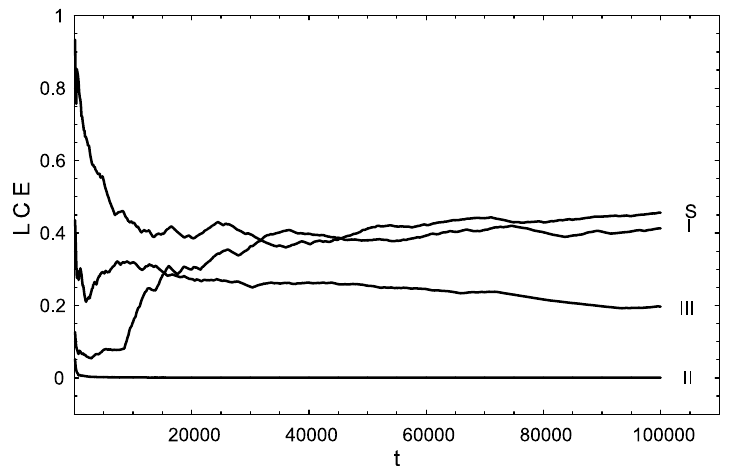
Fig. 8. Similar to Figure 5, but for the 3D